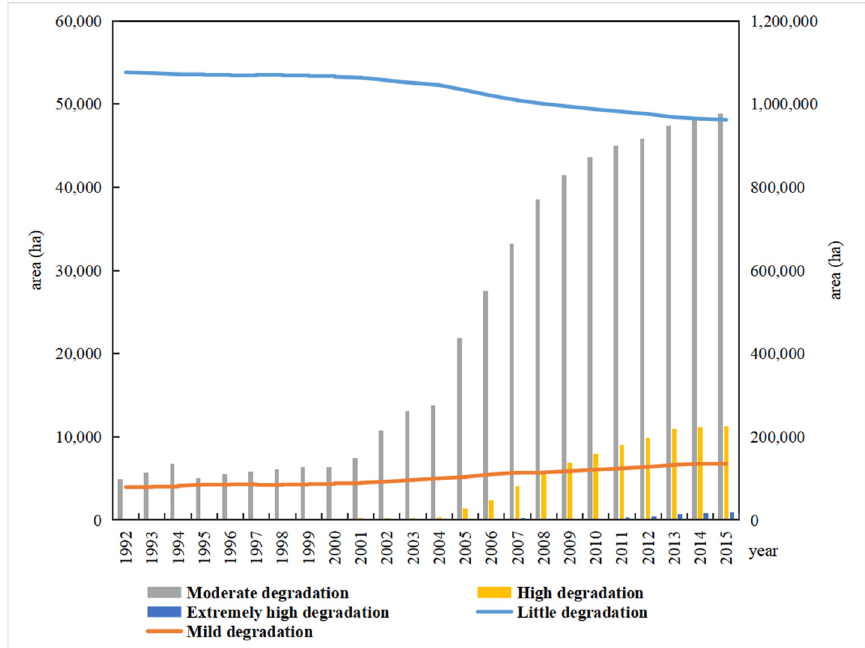
Figure 4. Statistical chart of the changes in the areas of habitat degradation in each county of Wenzhou City from 1992 to 2015.